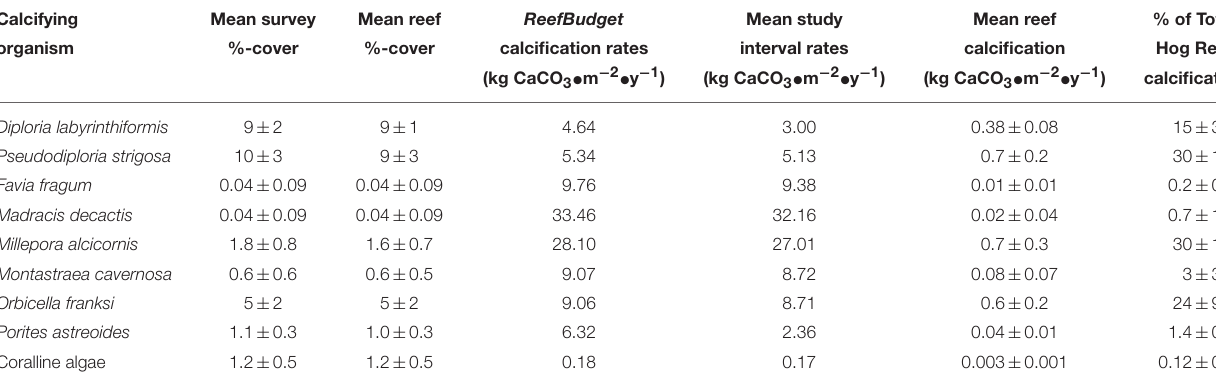
TABLE 1 | Summary table of calcification at Hog Reef.